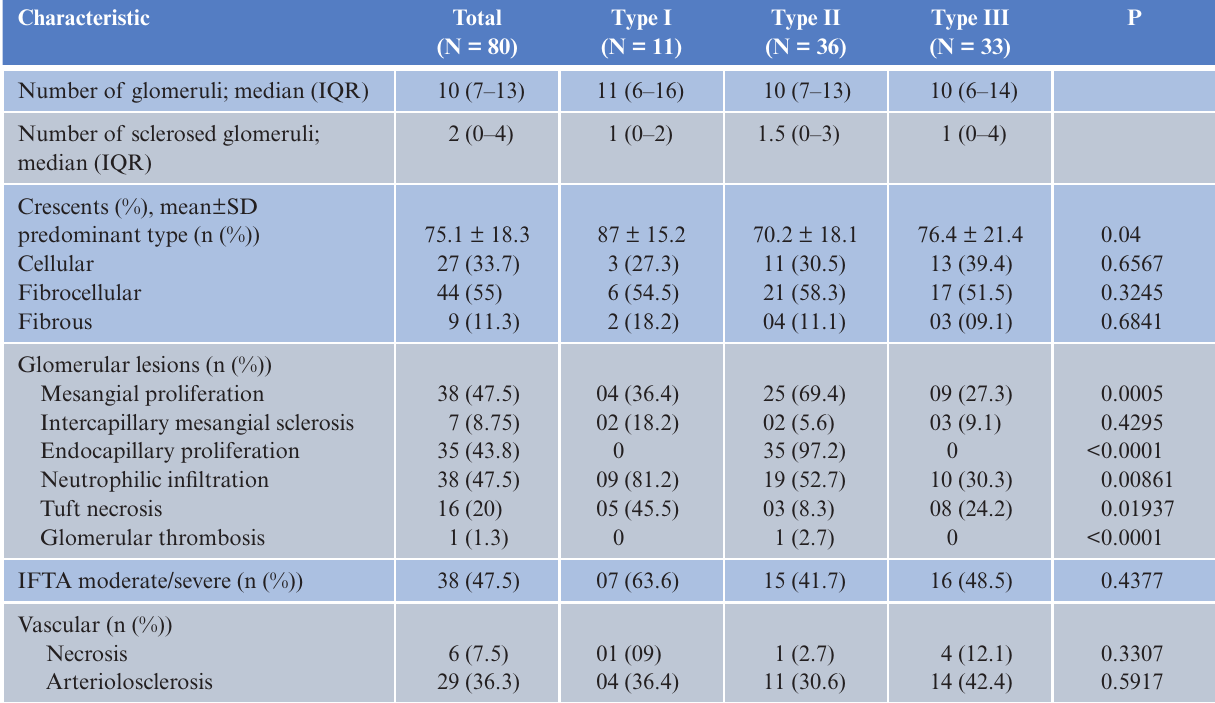
Table 3: Histopathology characteristics of the study population. Characteristic